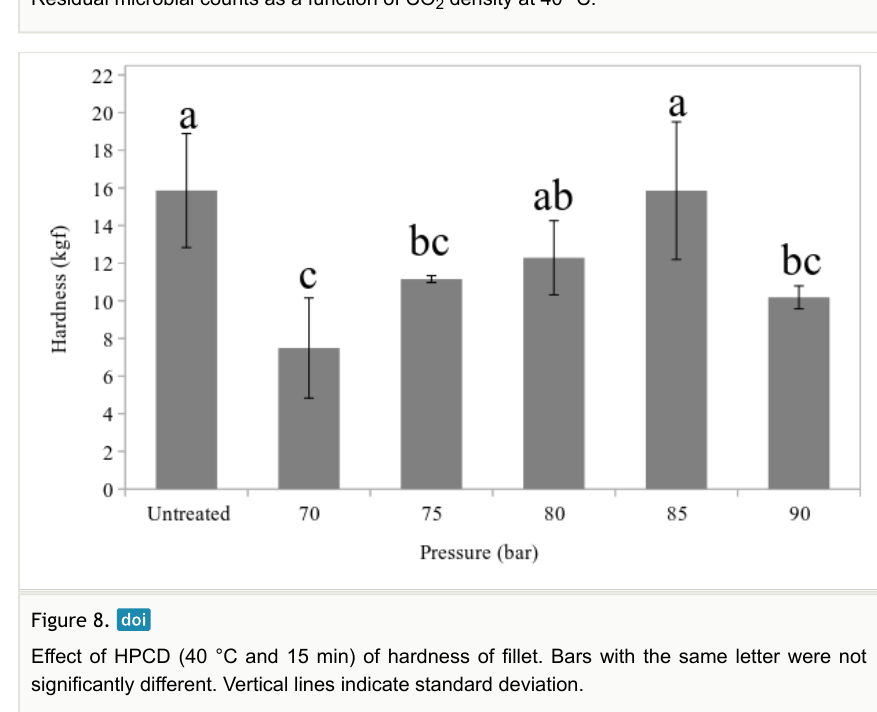
Figure 7. Residual microbial counts as a function of CO density at 40 °C. 2